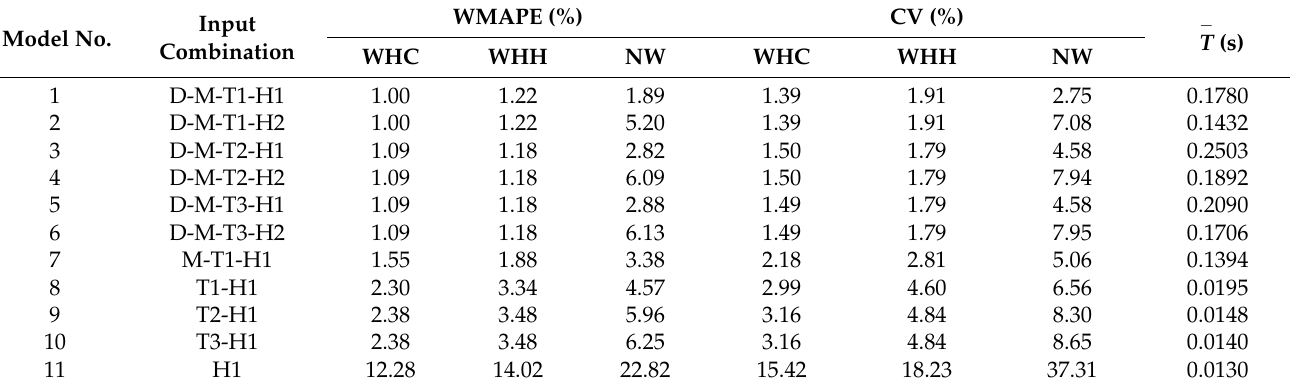
Table 7. Test results for lighting-plug system in different schedule input patterns in Case